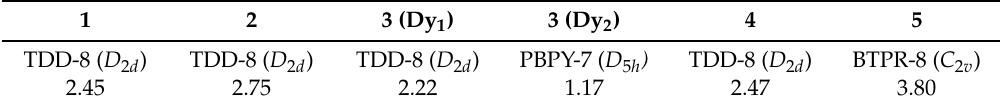
Table 2. Analysis of lanthanide coordination geometry using Shape